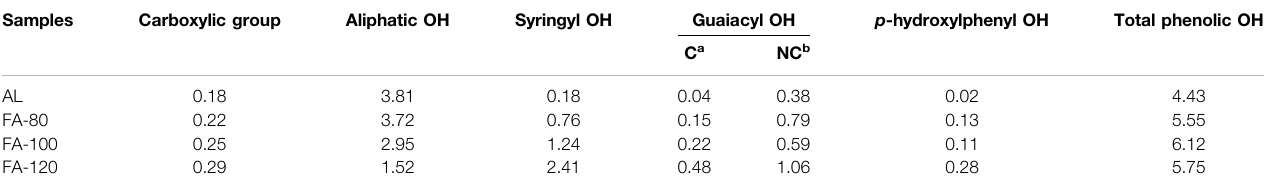
TABLE 2 | Quanti fi cation of the functional groups in the lignin samples by quantitative 31 P-NMR method. Samples